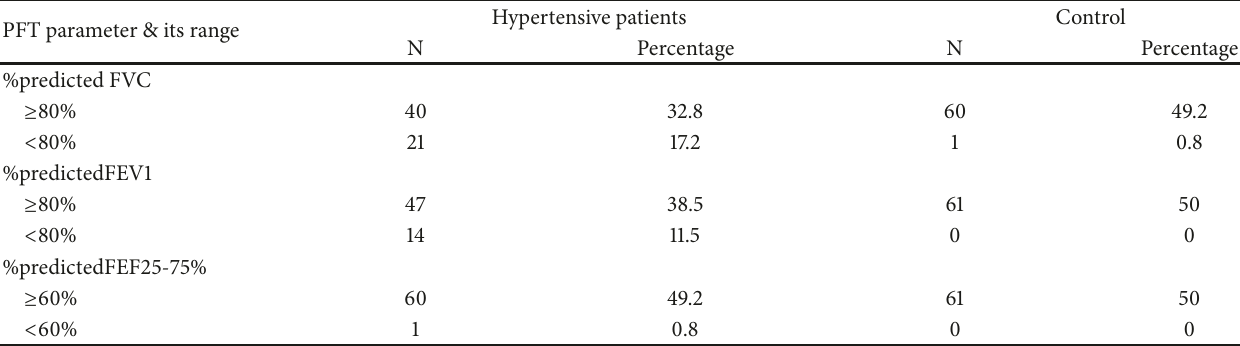
Table 6: Number of cases and controls on different ranges of percentage of predicted values of FVC, FEV1, and FEF25-75% at Zewditu Memorial Hospital, Addis Ababa, Ethiopia,